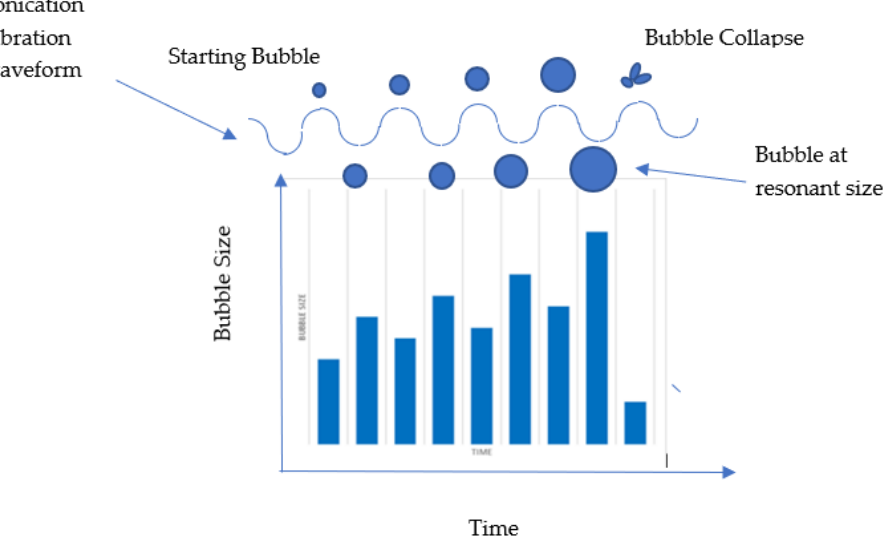
Figure 3. Cavitation bubble compression and expansion varying with the ultrasonic wave applied [22].